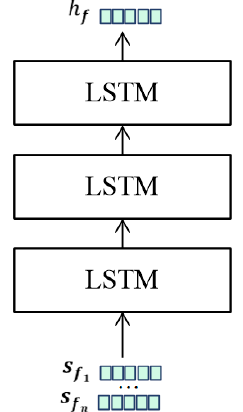
Figure 6. Framework of shared layer.